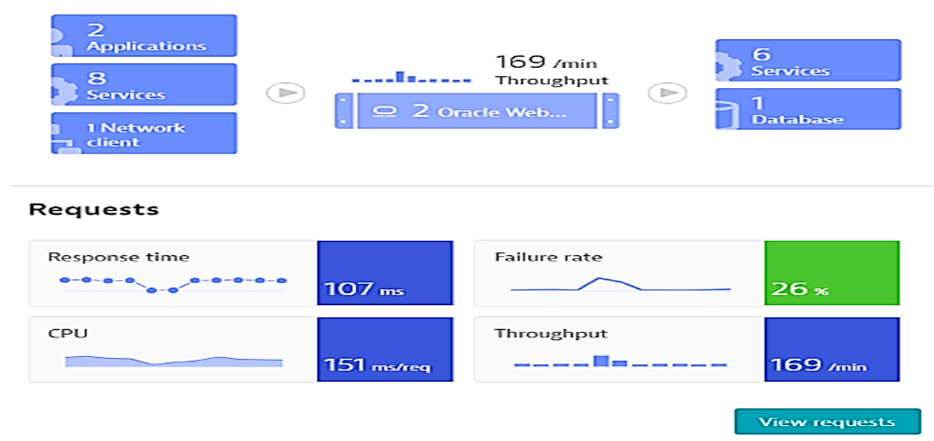
Figure 3. Monitored parameters and affected applications as shown by Davis AI for the specific case study.